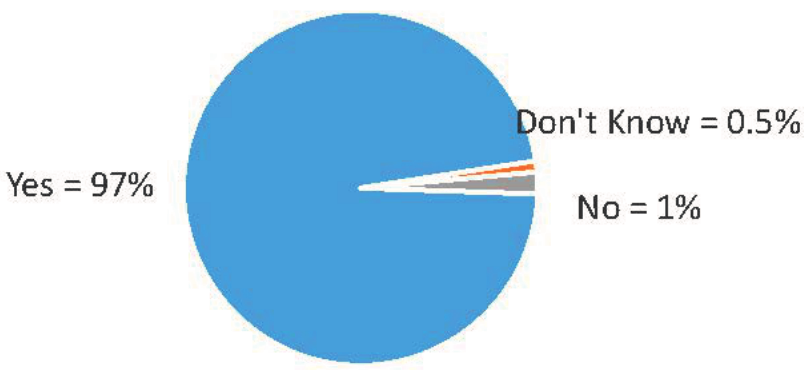
Figure 1. Proportion of African-American physicians who understand climate change is